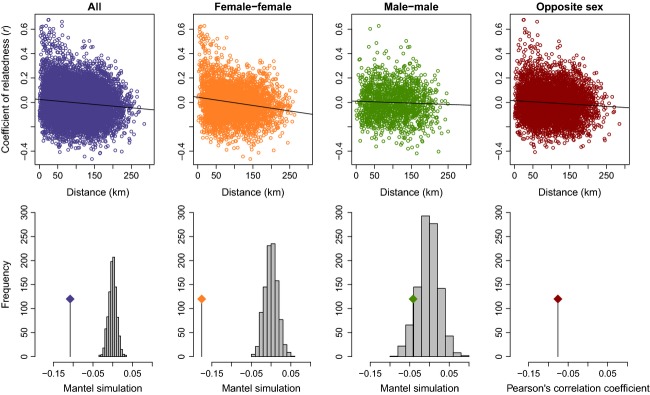
The top scatterplots have pairwise Euclidean distance on the X-axis and pairwise Lynch–Ritland coefficient of relatedness on the Y-axis and a linear regression line to indicate the overall trend for each of four categories of individuals designated as putative parents: all pairs, female–female pairs, male–male pairs, and opposite-sex pairs. The bottom graphs show the results of a Mantel test for IBD (isolation by distance) for each of the above-mentioned categories with the exception of opposite-sex pairs, which are represented with the Pearson’s correlation value. The further away the test statistic is from the simulated bars, the greater the significance of IBD.